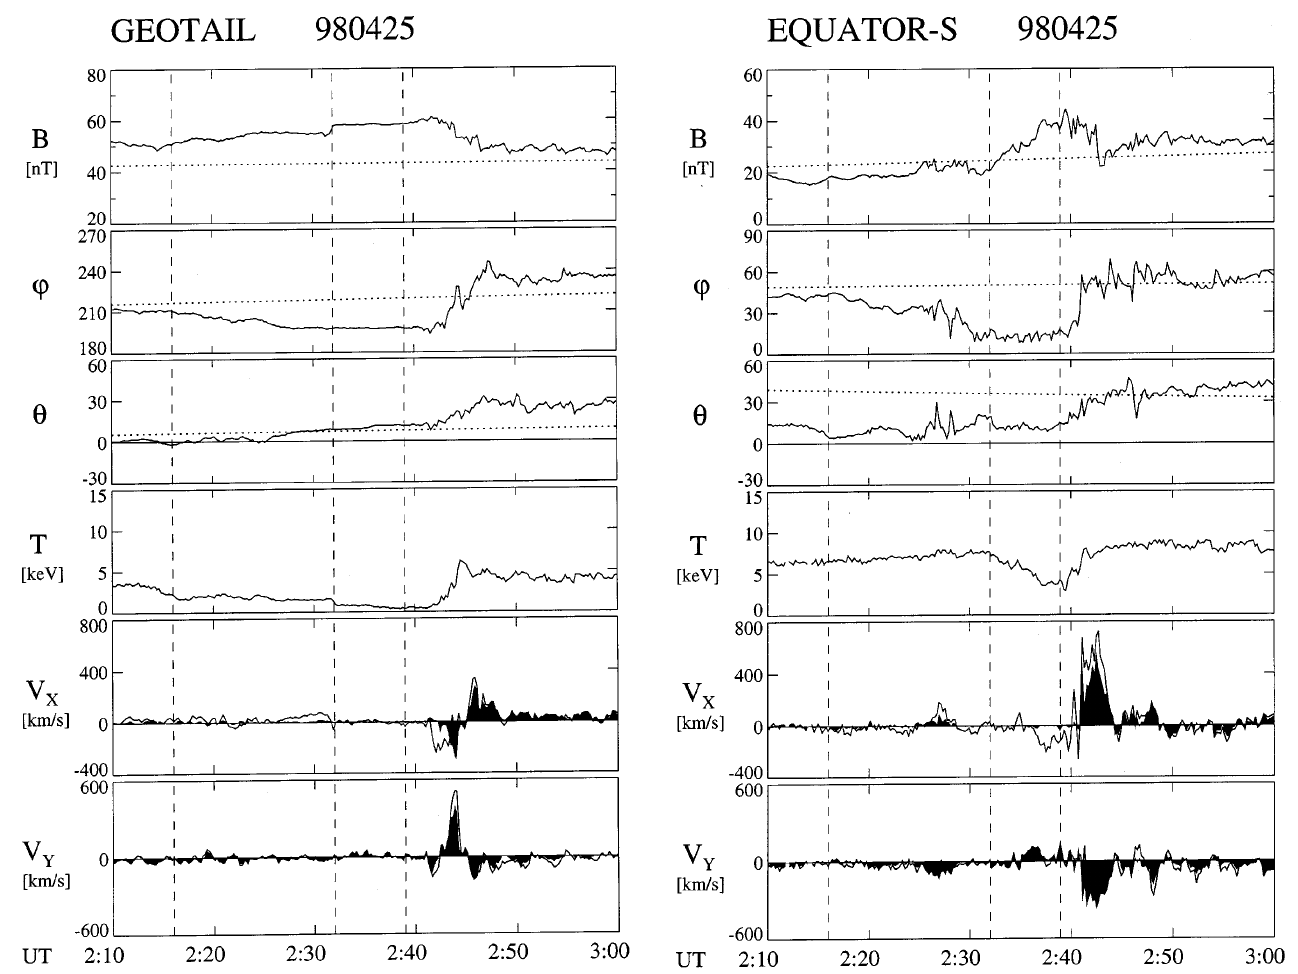
Fig. 7. Magnetic field and plasma data from Equator-S in the same format as